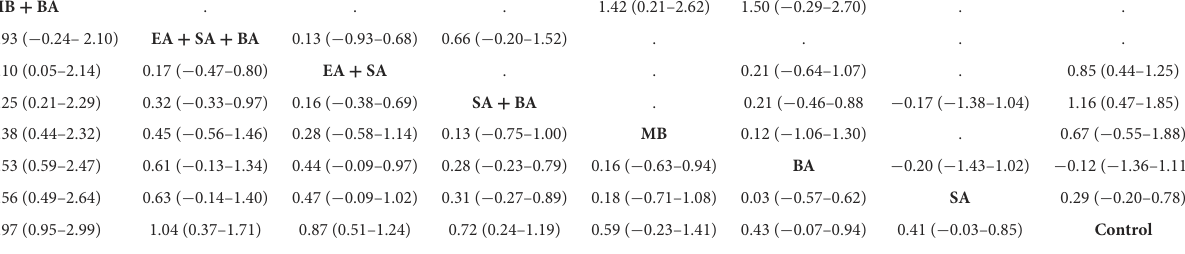
TABLE 4 Results of network meta-analysis for all possible treatment effects (living